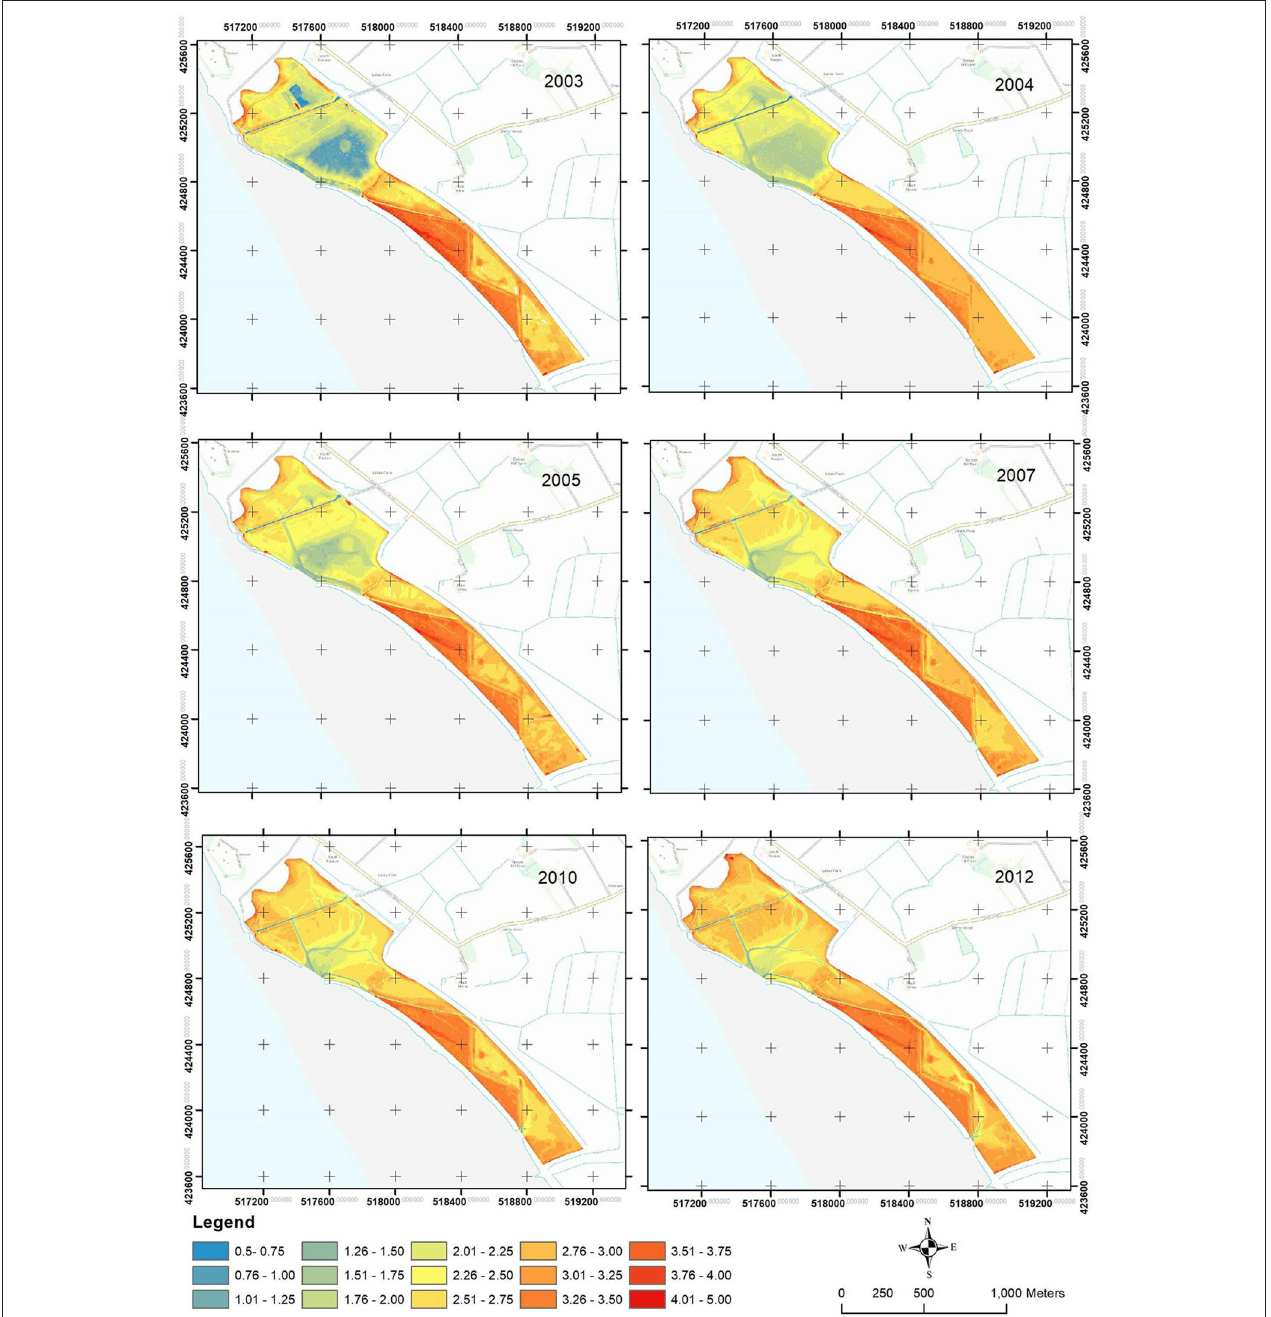
FIGURE 2 | Changes in the elevation in the MR site between 2003 (Year 1) and 2012 (Year 10) derived from a digital terrain model (DTM). For the dates of the measurements, see Table 2